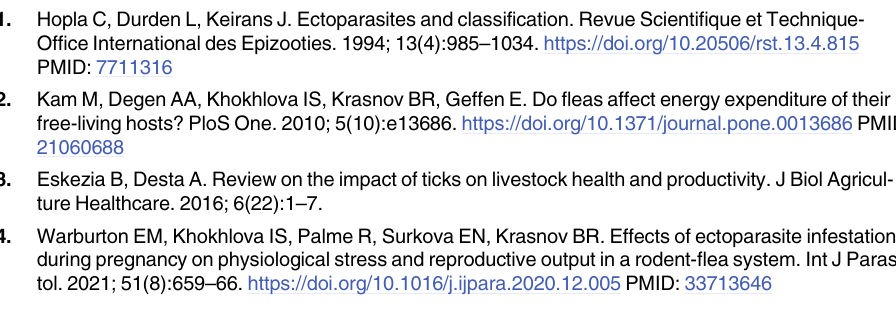
S1 Table. Ectoparasite and landscape data used in analysis.